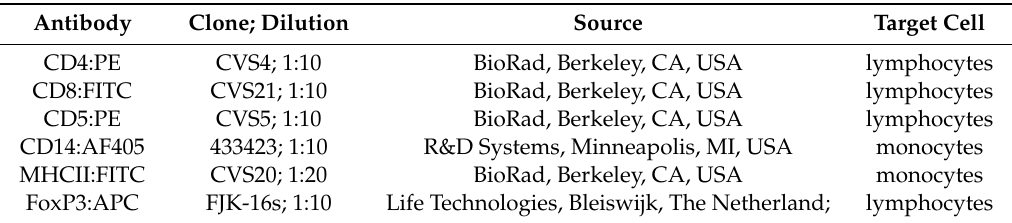
Table 1. List of monoclonal antibodies used for labeling peripheral blood mononuclear cells (PBMCs) for flow